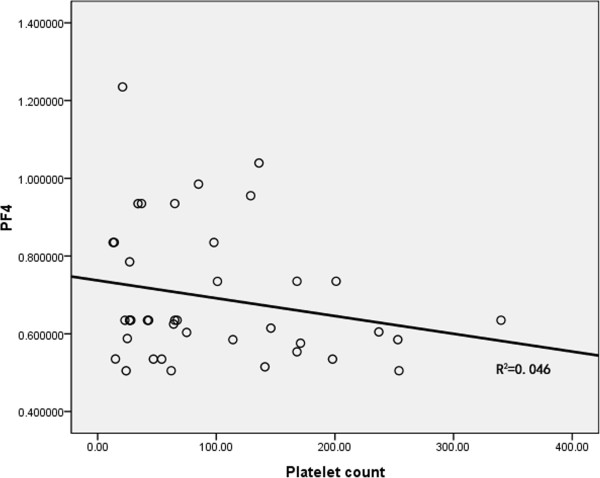
Correlation analysis between serum PF4 and platelet count in newly diagnosed AML.